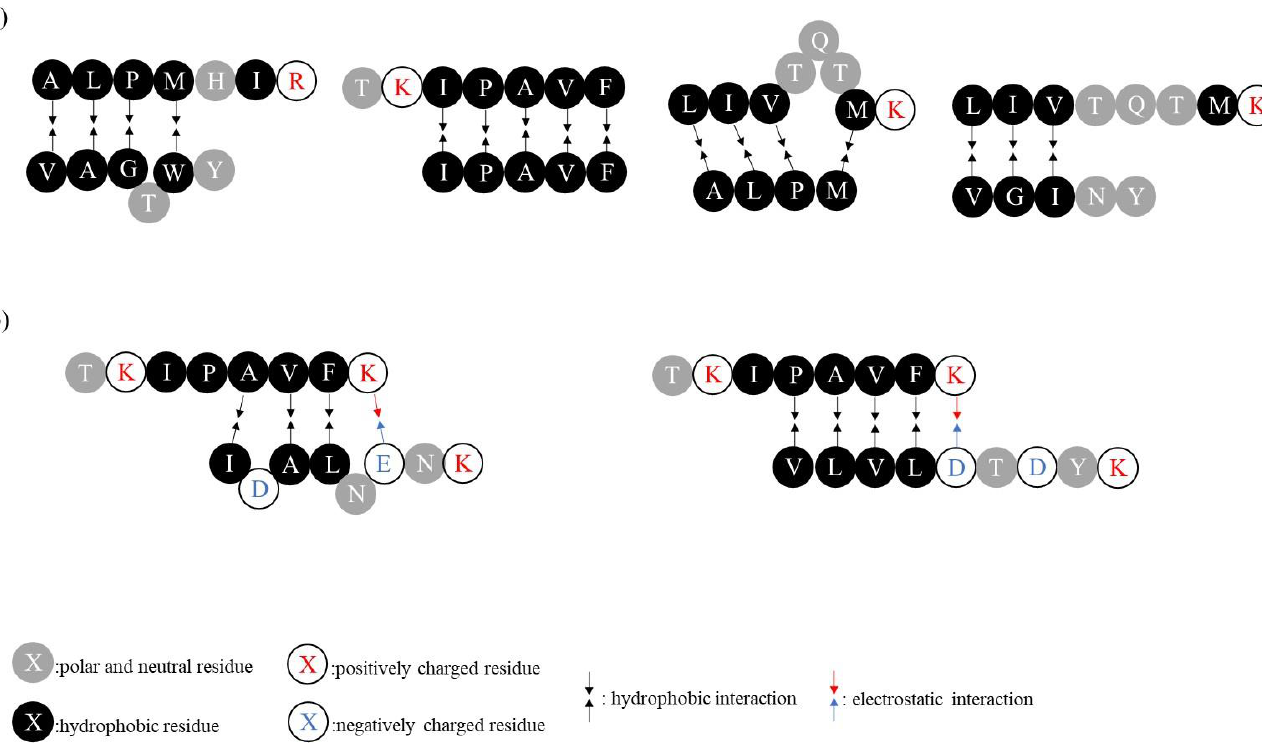
Figure 4. Potential interactions between positively charged peptides and ( a ) neutral peptides or ( b ) negatively charged peptides to form globally positively charged aggregates that can migrate during EDUF treatment.